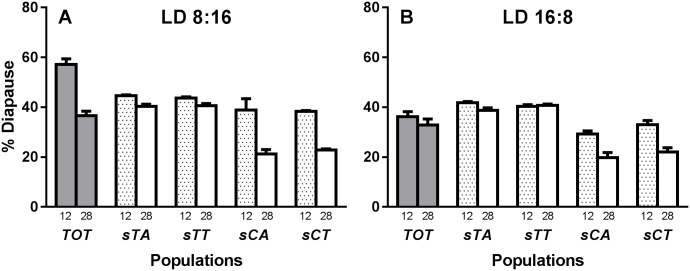
Diapause incidence in the Treviso population (TOT) and in the four sublines (sTA, sTT, sCA and sCT).Y axis: percentage diapause averaged among 5/6 replicates (±SEM). A) Diapause in LD 8:16 at 12 and 28 days (dotted and plain bars respectively). B) Diapause in LD 16:8. Gray bars: Treviso population. For a description of the genotypes of the populations see Table 2.